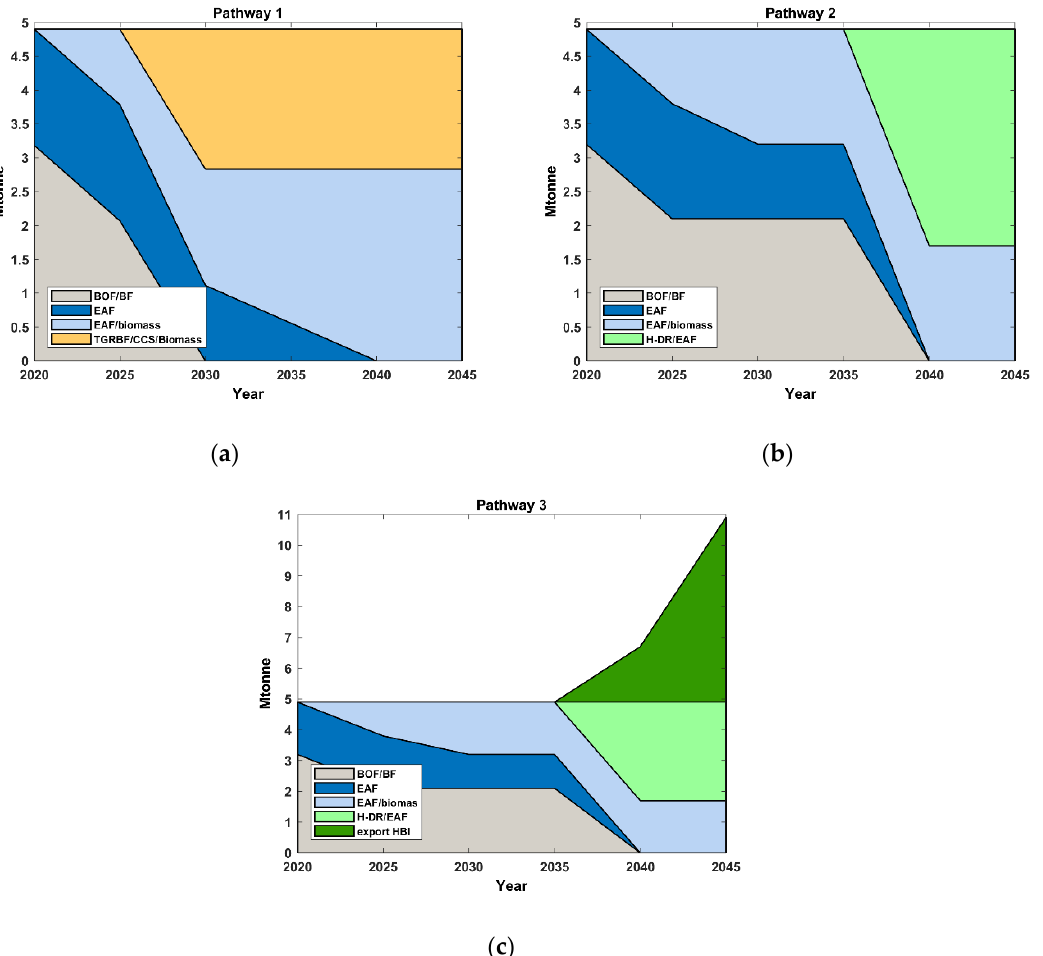
Figure 2. Production processes mix for the Swedish steel industry in Pathway 1 ( a ), Pathway 2 ( b ) and Pathway 3 ( c ) from 2020 to 2045. Note the different scale of the y-axis of Figure 2c.